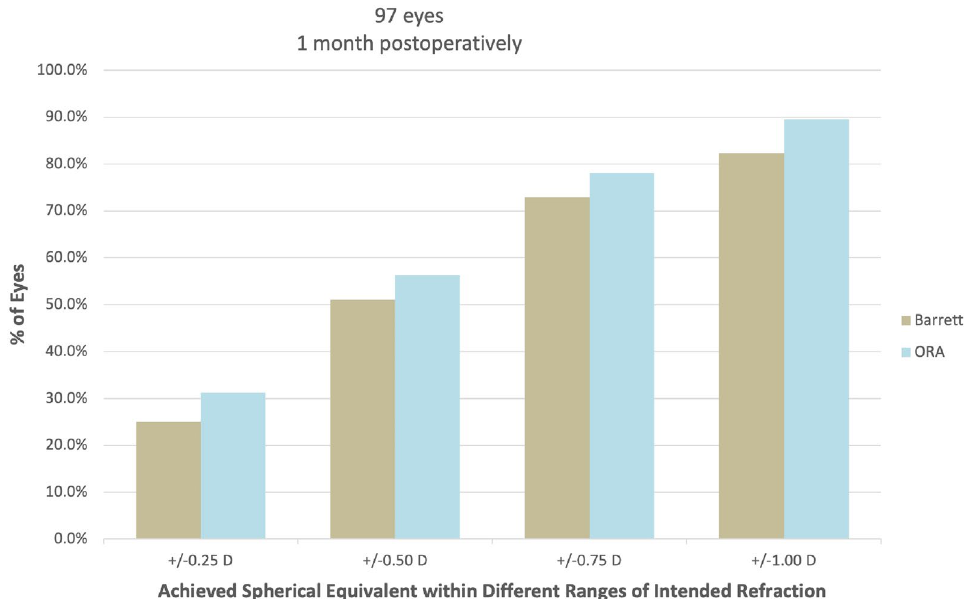
Figure 2. Graphical depiction of difference in achieved spherical equivalents between the preoperative and intraoperative methods. There was no statistically significant difference between the two methods for an intended target refraction up to ± 0.75